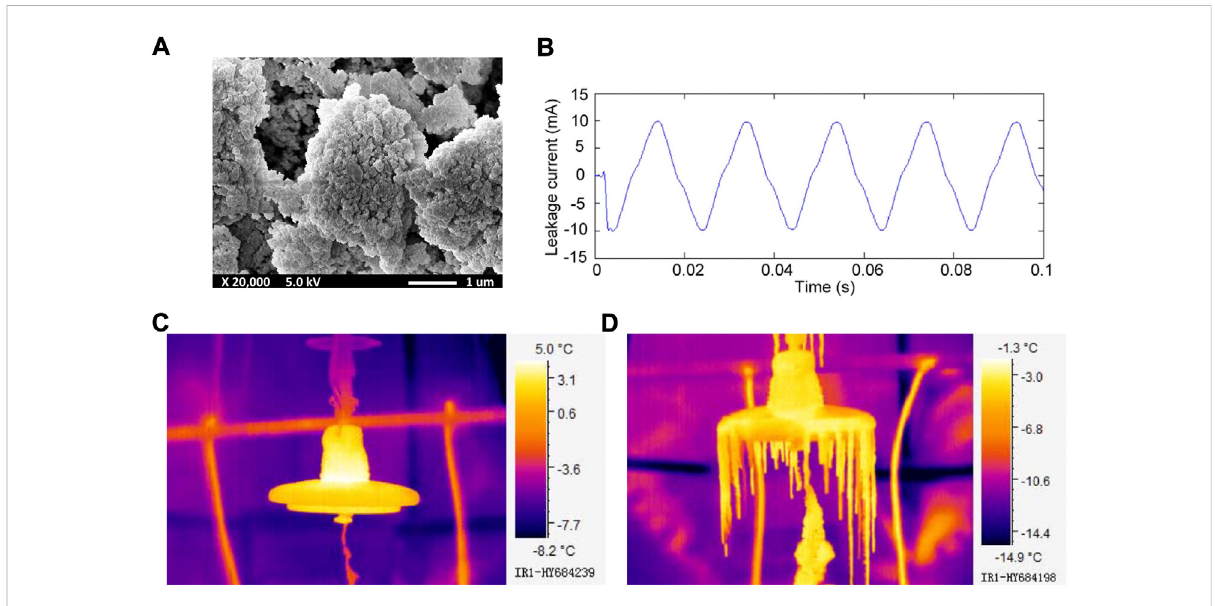
FIGURE 8 (A) The SEM image of the carbon/nano-silica/PDMS coating (Li et al., 2016). (B) Typical leakage current waveforms of insulators with carbon/ nano-silica/PDMScoating(Yanetal.,2016).Thermalinfraredimagesoftestedinsulatorsafter1.5 henergizedicing: (C)